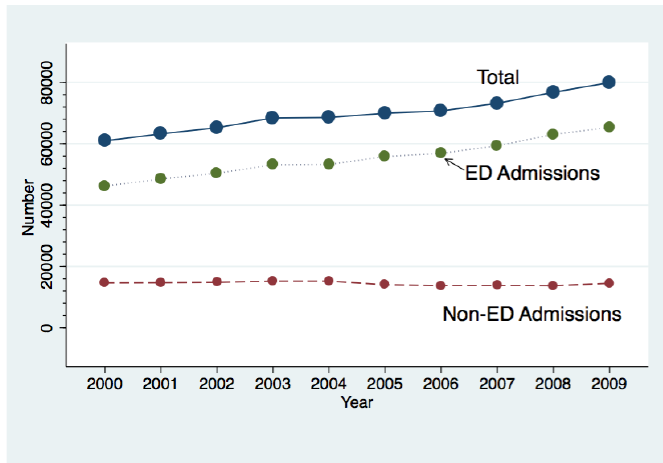
Figure 2. Invasive mechanical ventilation (IMV) discharges in California from